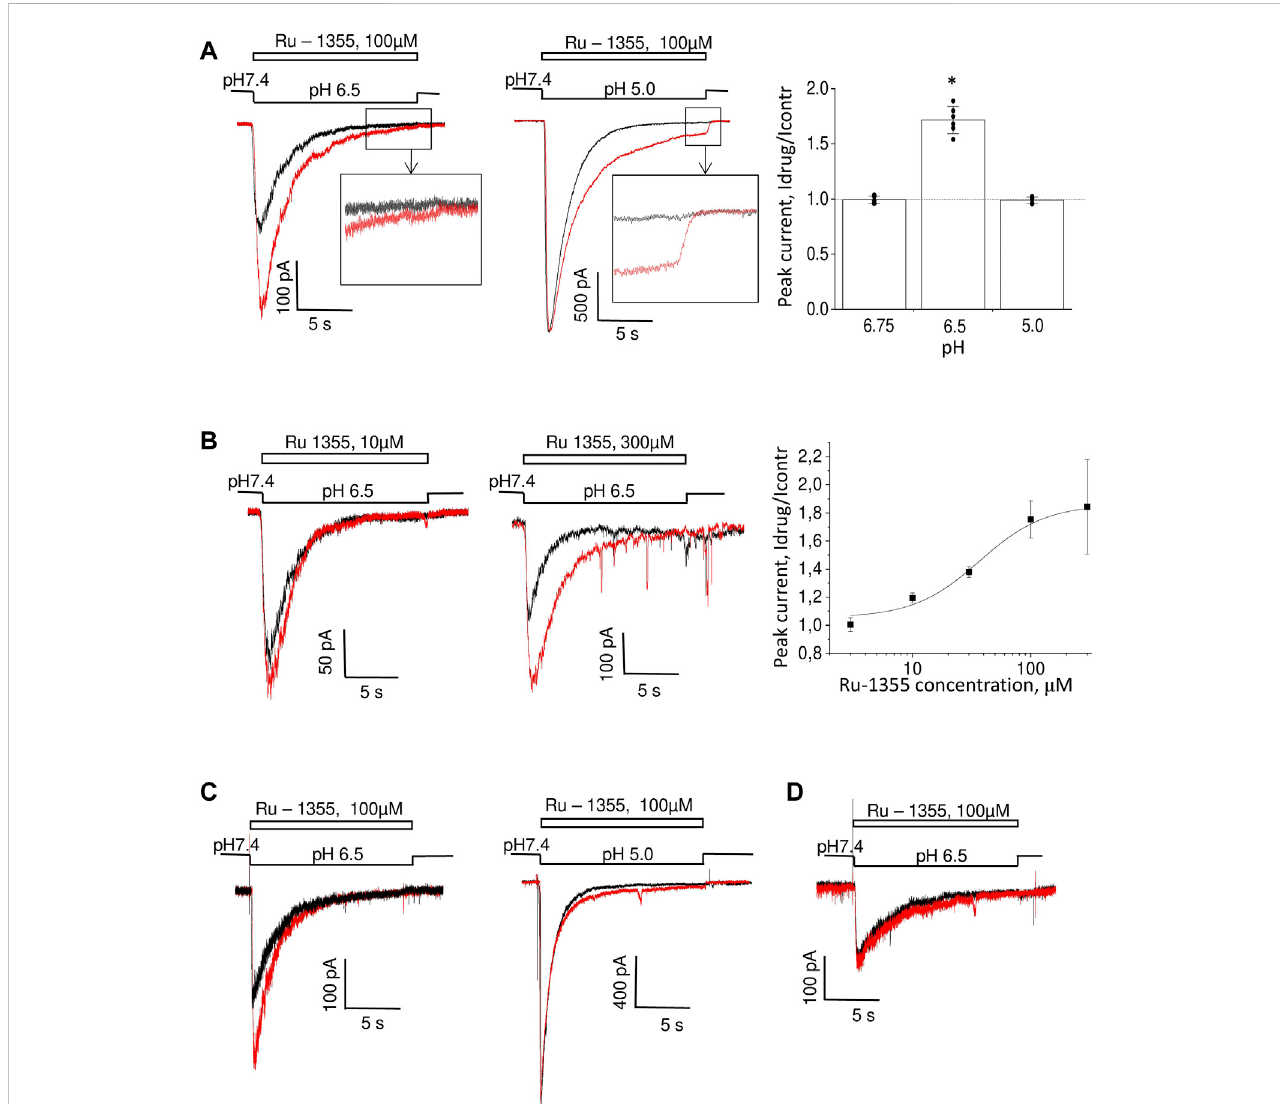
FIGURE 4 Action ofRu-1355onnative ASICs.Responsesinthecontrol conditionareshown inblack;responsesinthepresenceofthedrugareshowninred. (A,B) , action on cortex pyramidal neurons. (A) , pH dependence of theaction. Ru-1355 causes a signi fi cant increase in theresponse to modest (pH6.5) acidi fi cation. The amplitude of the response to strong (pH 5.0) acidi fi cation is not affected, but the drug causes a signi fi cant steady-state response. (B) , concentration dependence of the action. At 10 μ M, the drug causes a subtle effect; at 300 μ M it causes a saturating effect. (C) effect on striatal interneurons. The response is potentiated at pH 6.5 (left) but not at pH 5.0 (right). (D) responses in hippocampal pyramidal neurons are insensitive to